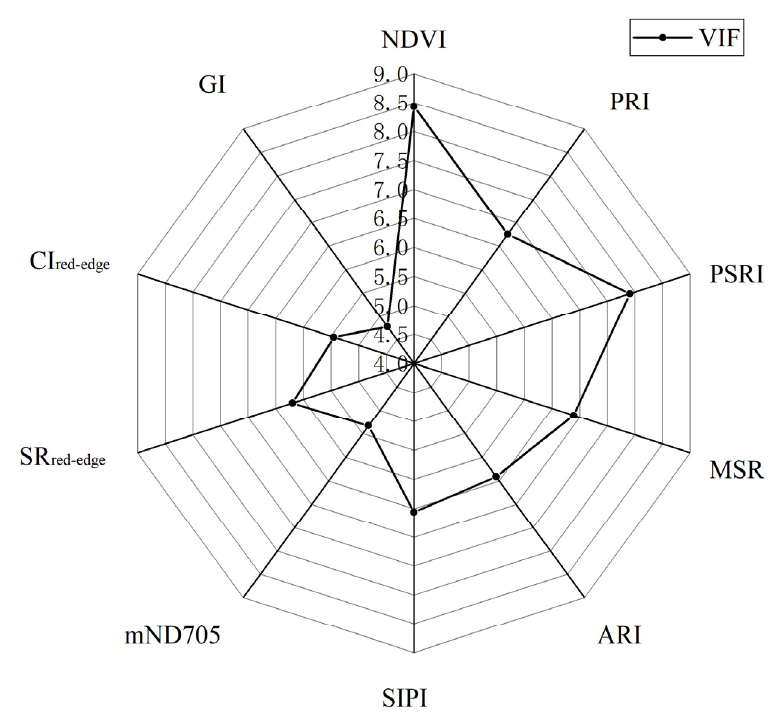
Figure 8. VIF test for characteristic variables.